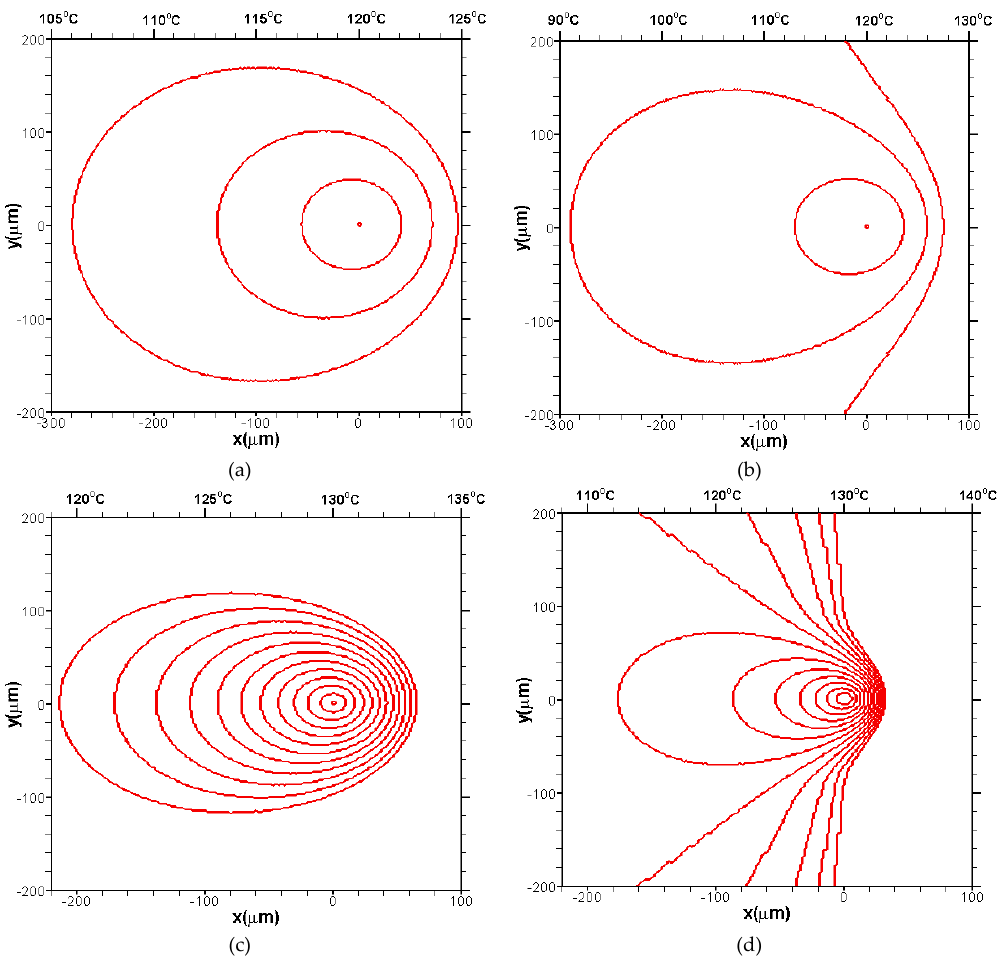
Figure 4. Spherulite shapes predicted by morphological Monte Carlo method: ( a ) T Λ = 50 K/mm, ( b ) T = 120 ◦ C, Λ = 100 K/mm, ( c ) T 0 Λ = 100 K/mm. Crystals 2019 , 9 , x FOR PEER